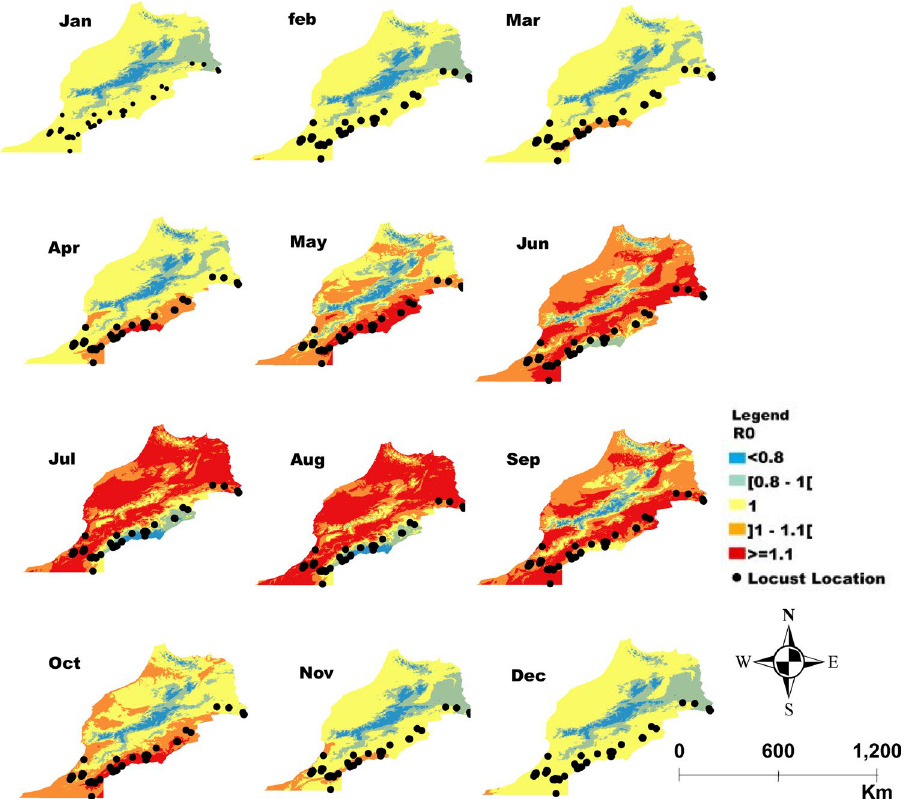
Figure 2. Morocco: Monthly spatial projection of the variation in R 0 as a function of temperature and relative humidity reflecting the potential efficiency of the entomopathogenic fungus Metarhizium acridum as a biocontrol agent against desert locust. The area in red in each month are areas where R 0 > 1 correspond to zones with potential higher efficiency and hence successful fungal biocontrol agent application against locusts while the area in orange ( R 0 ≈ 1) can also be targeted but with less potential efficacy. Application in areas in yellow and blue ( R 0 < 1) will probably not be efficient. The dots correspond to the reported point incidence of locusts in